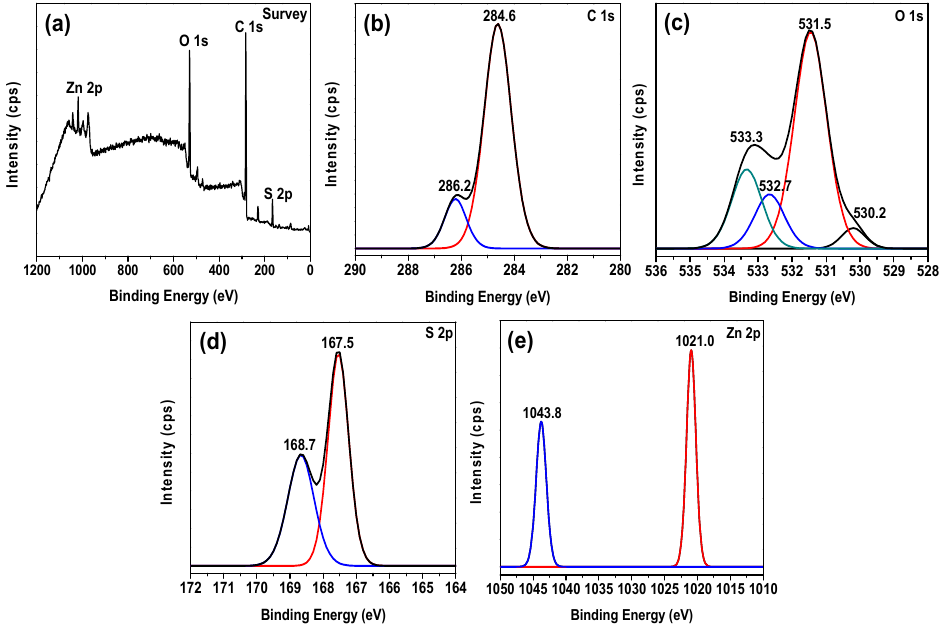
Figure 5. ( a ) X ‐ ray photoelectron spectrums (XPS) survey spectrum and high resolution spectrums of ( b ) C 1s, ( c ) O 1s, ( d ) S 2p, and ( e ) Zn 2p of PES/ZnO (PZ ‐ 17) hybrid film photocatalyst.